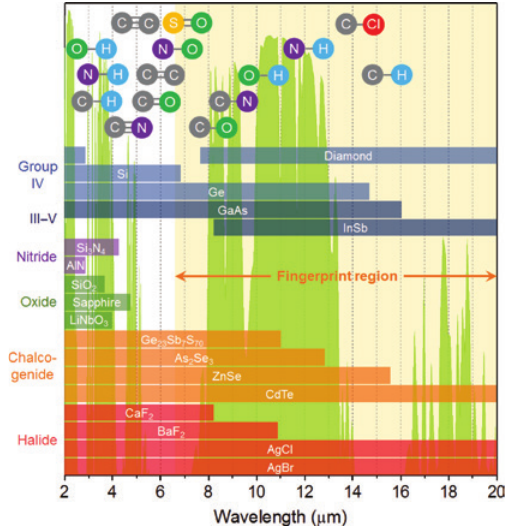
Figure 1: The mid-IR spectral regime: the bars represent optical transparency windows (where material attenuation is < 1 dB/cm) of various materials, the top panel depicts the spectral locations of the primary absorption bands of different chemical bonds, and the background shows the infrared atmospheric transmission